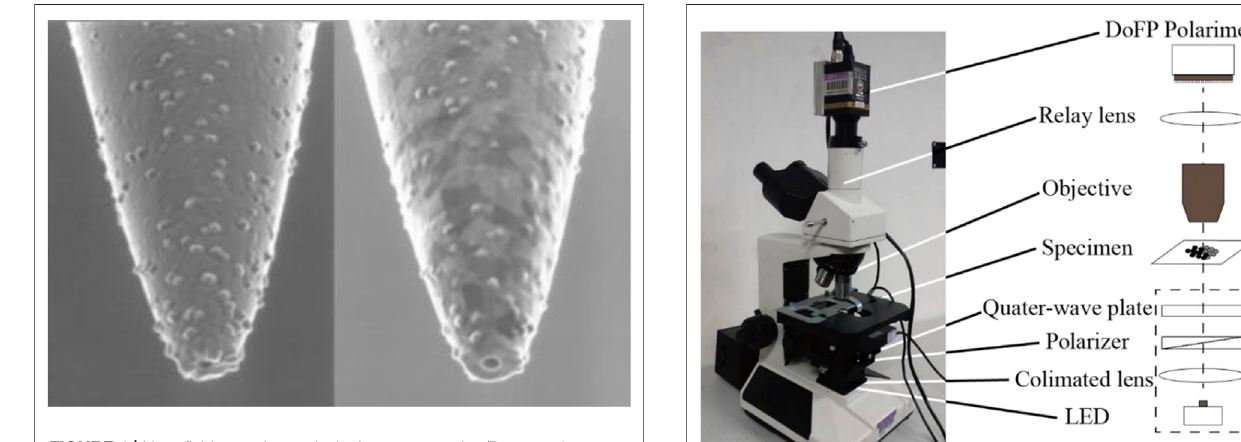
FIGURE 1 | Near- fi eld scanning optical microscope probe (Dunn et al., 2009).